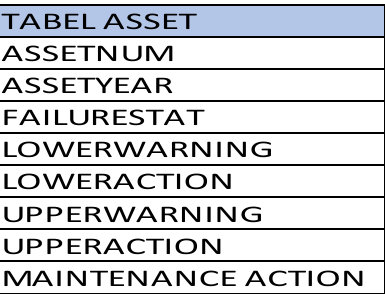
Fig. 6. Data to be used for the data mining process